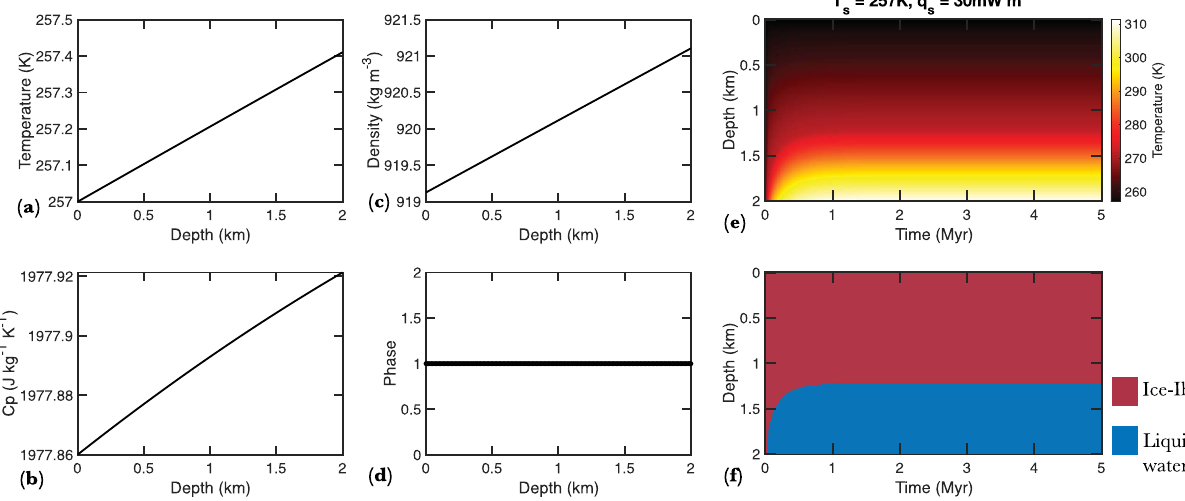
Fig. 3 | Steady state initial pro fi les of various thermophysical parameters, temperature, and ice phases as a function of depth within a thick ice sheet on Proxima Centauri B assuming a surface temperature of 257K. a An example of initialsteady-statepro fi lesoftemperature( a ),speci fi cheat( b ),density( c ),andice- phase ( d ) as a function of depth in a 2km thick ice sheet on exo-Earth Proxima CentauriBassumingasurfacetemperatureof257K.Thetemperatureisassumedto increasewithdepthinanadiabaticfashion.Theseinitialpro fi